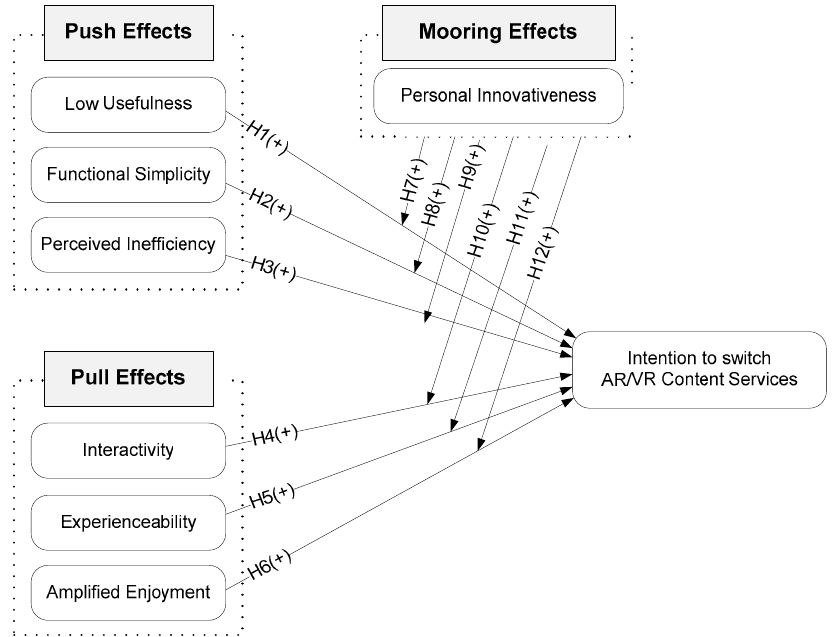
Figure 1. Research model and hypotheses.